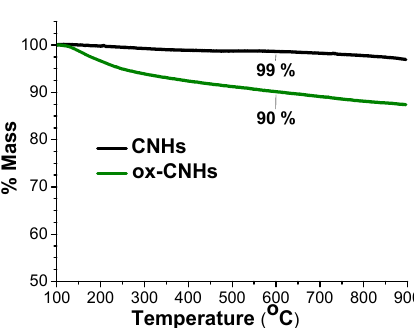
Figure 2. Thermograms of CNHs before (black) and after oxidation treatment (green). The difference in the weight loss confirms the functionalization.